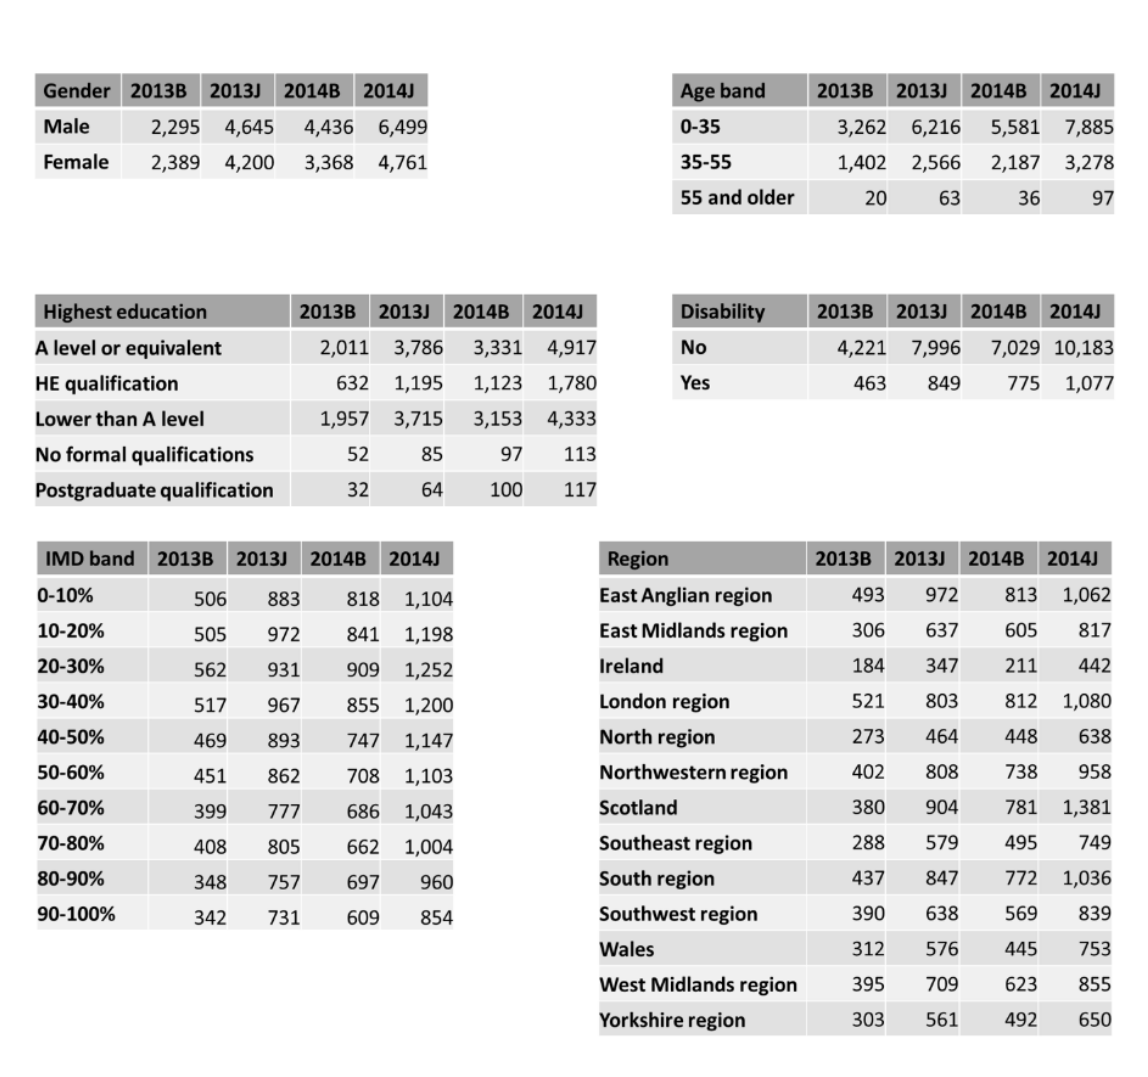
Summary of Learner Demographics and